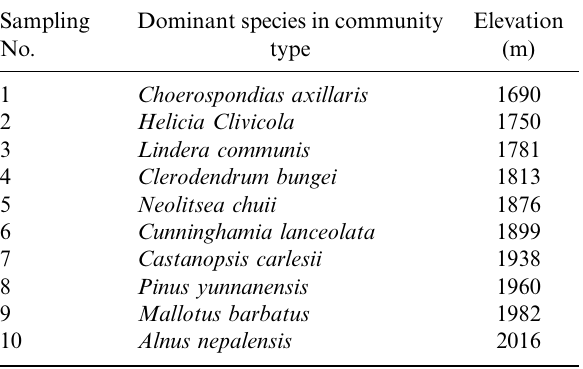
Table 1. The dominant species and elevation of communities